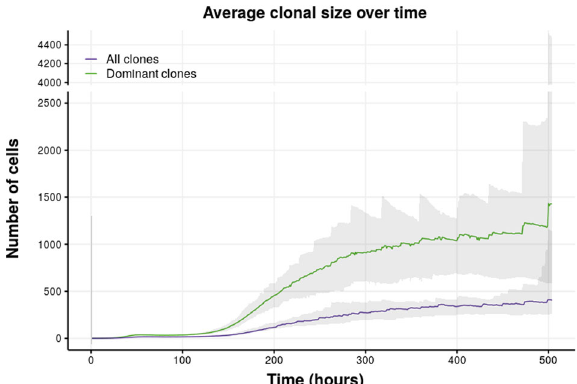
Fig. 5 Results from nine simulations showing the evolution of the average clonal sizes of all clones (purple) and all the dominant clones (green) during a 21-day GC reaction. The y axis is gapped between 2500 and 4000 cells to facilitate the visualization. Dominant clones were de fi ned as those with abundances higher or equal than the 75th percentile of clonal abundances. The shaded area represents the minimum and maximum of the mean values for each group obtained from the simulations. When the number of clones within a group is low, changes on its clonal composition (a clone may stop belonging to the group because it stops fi tting the criteria or because it is outcompeted and removed) lead to big changes in the means.